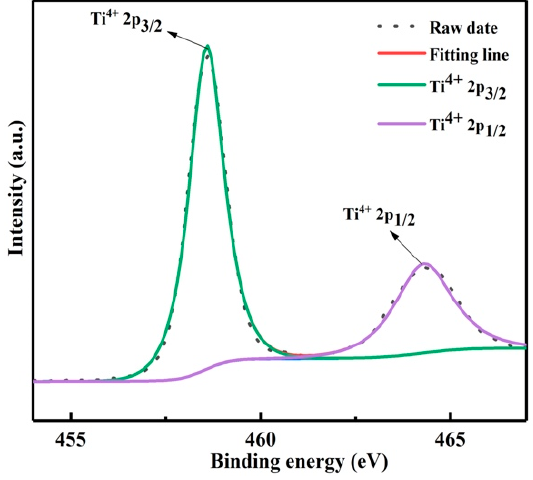
Figure 7. XPS survey spectrum of Ti 2p. Table 2. Chemical composition of the product (wt%).